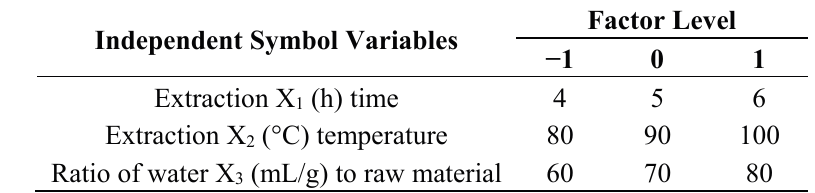
Table 1. Factors and levels in the Box-Behnken design used to examine extraction yield of G. livida (Harv.) Yamada (GL) polysaccharides.